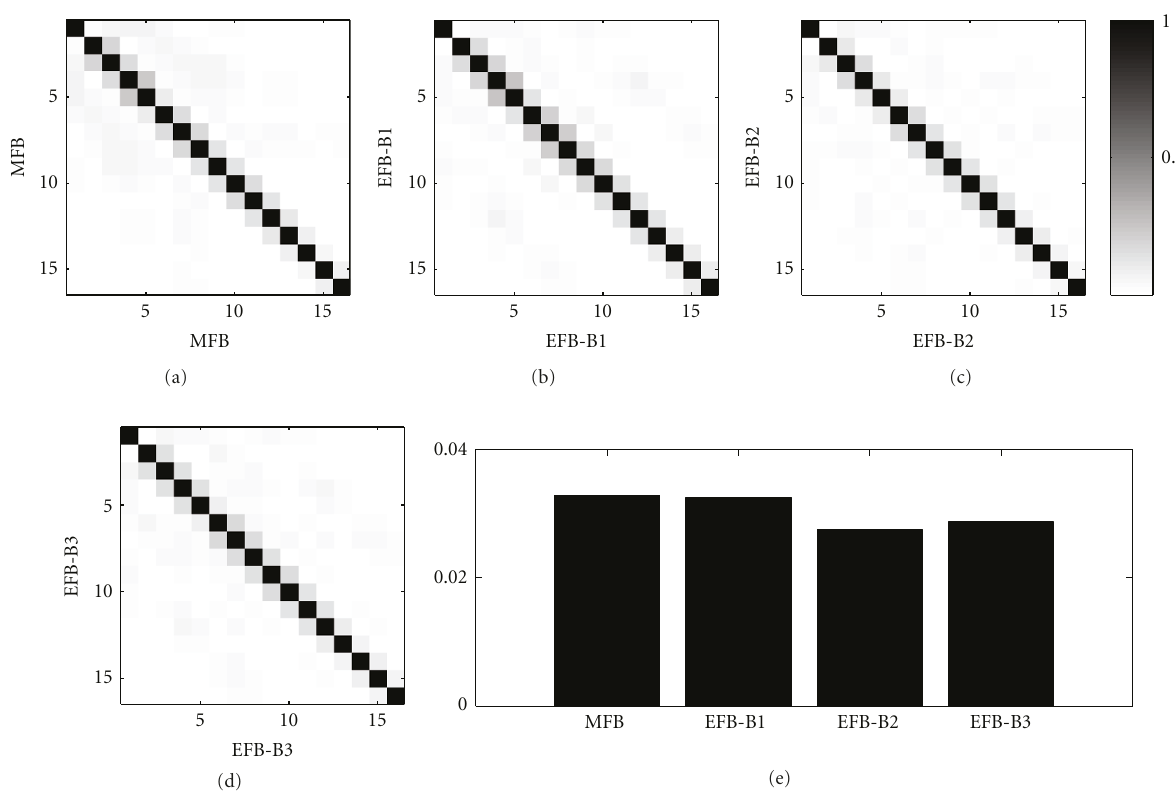
Figure 11: Squared Pearson’s correlation of MFCC and ESCC obtained with EFB-B1, EFB-B2, and EFB-B3 ((a), (b), (c) and (d), resp.). Normalized sum of the correlation coe ffi cients outside the diagonal